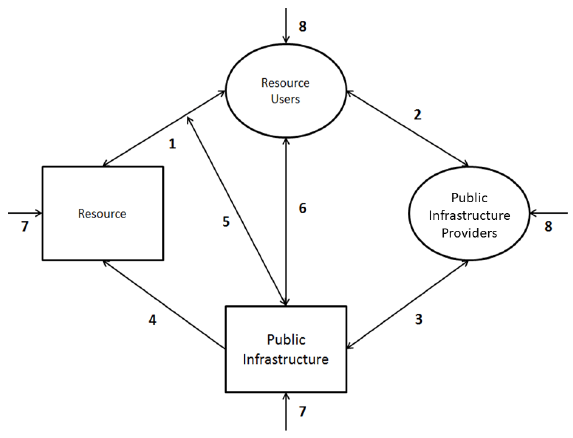
Fig. 4 . The conceptual model of the robustness framework as introduced by Anderies et al. (2004). It specifies four generic components common to most social-ecological systems (resource, resource users, public infrastructure, and public infrastructure providers) and their interactions (Links 1 to 6). It also describes the presence of external disturbances (Links 7 and 8). Boxes refer to biophysical components of the system whereas circles refer to social